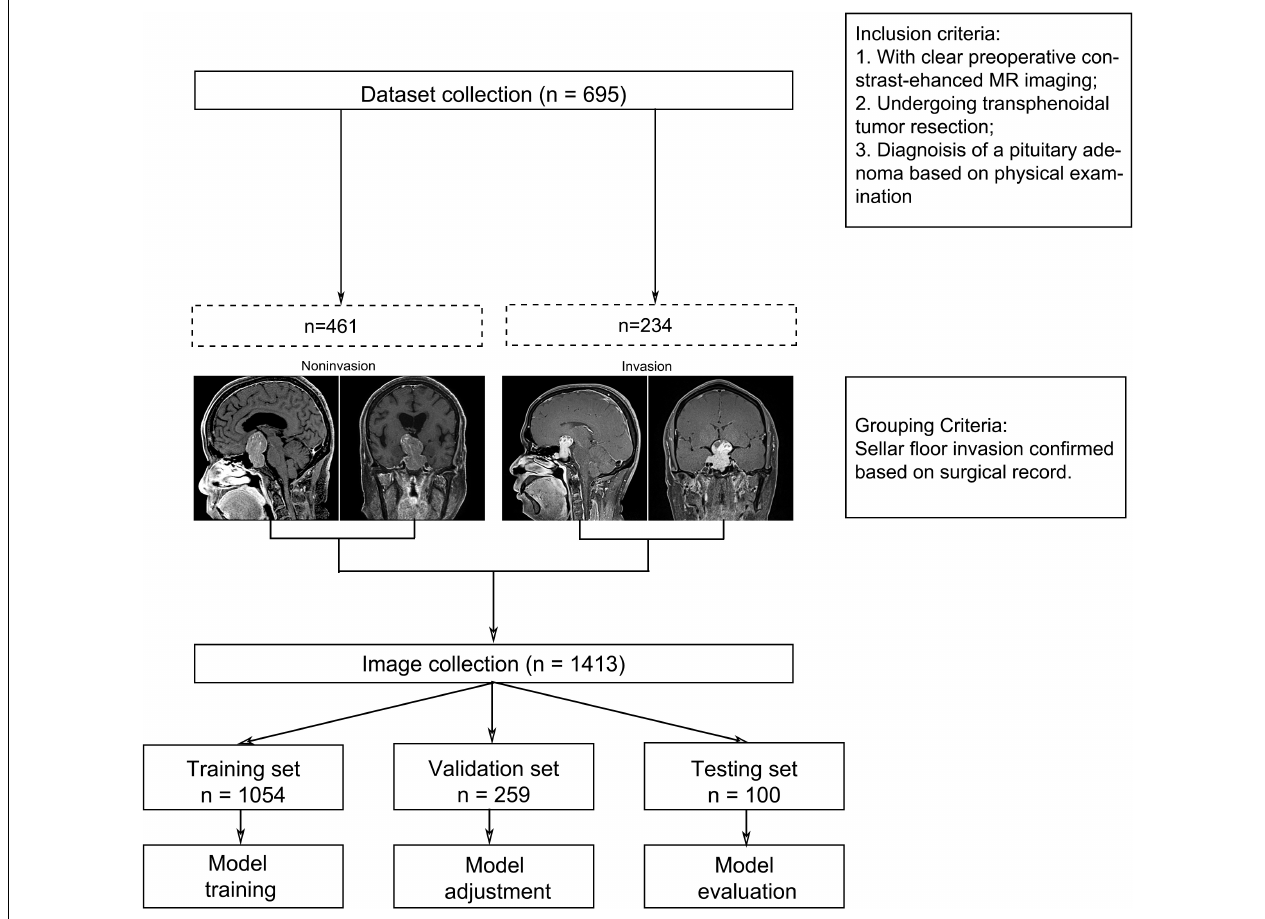
FIGURE 1 | Image data collection